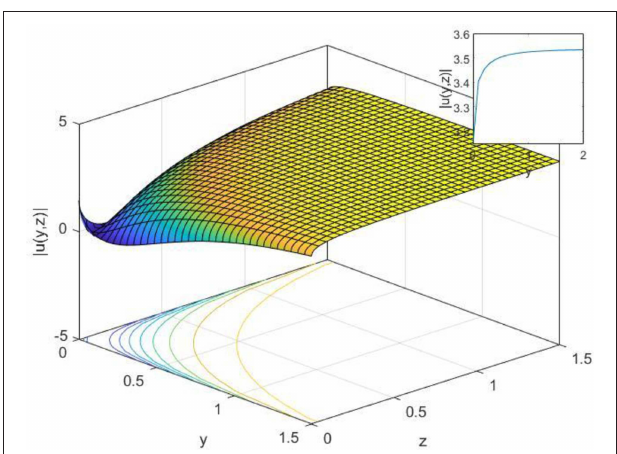
FIGURE 10 | 2-D, 3-D, and contour plot of Equation (30), when t γ 0.2, α 0.5, β 0.6 and z = = =